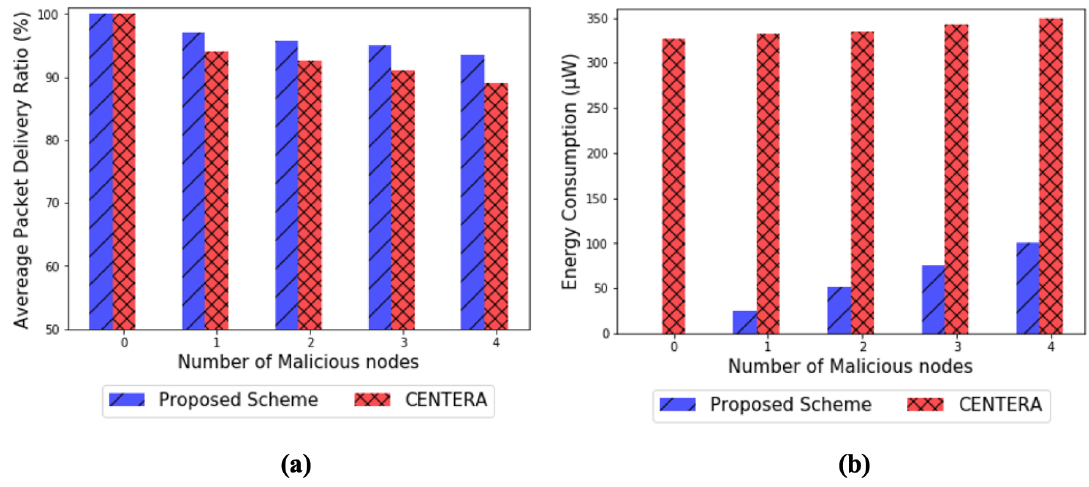
Figure 10. ( a ) Packet delivery ratio and ( b ) energy consumption in the case of Gray-hole attack by varying number of malicious